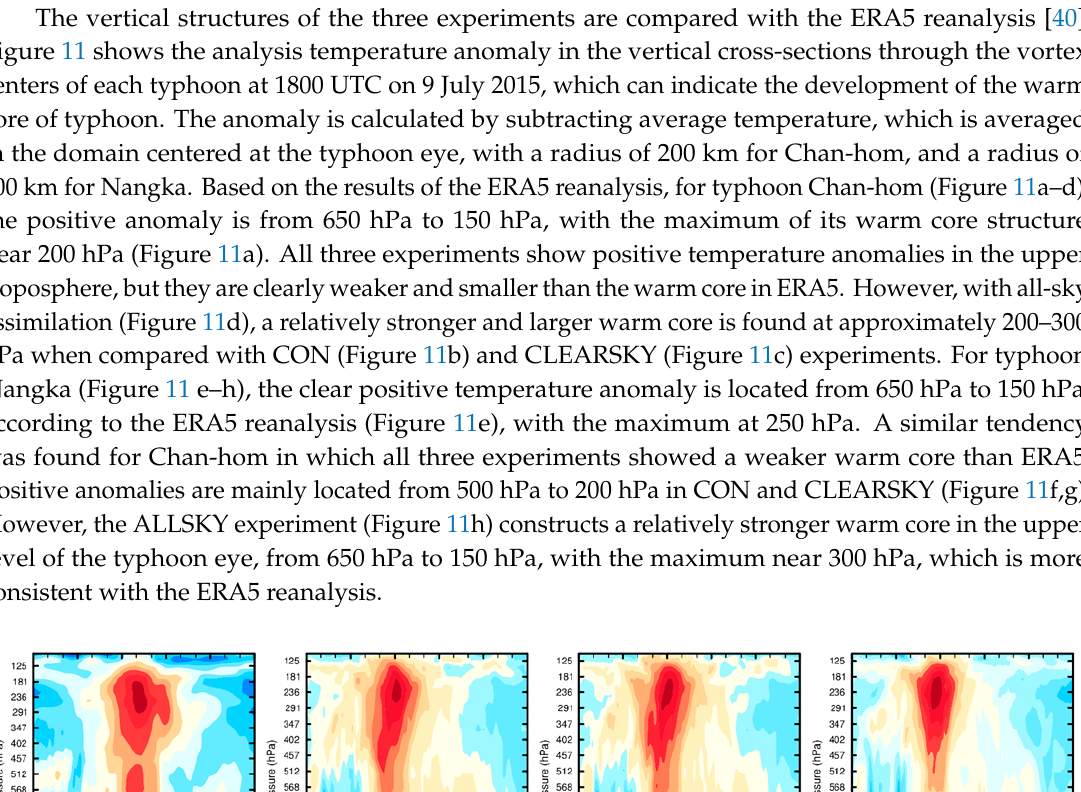
Figure 10. The same as Figure 9, but for central sea-level pressure (CSLP) error.